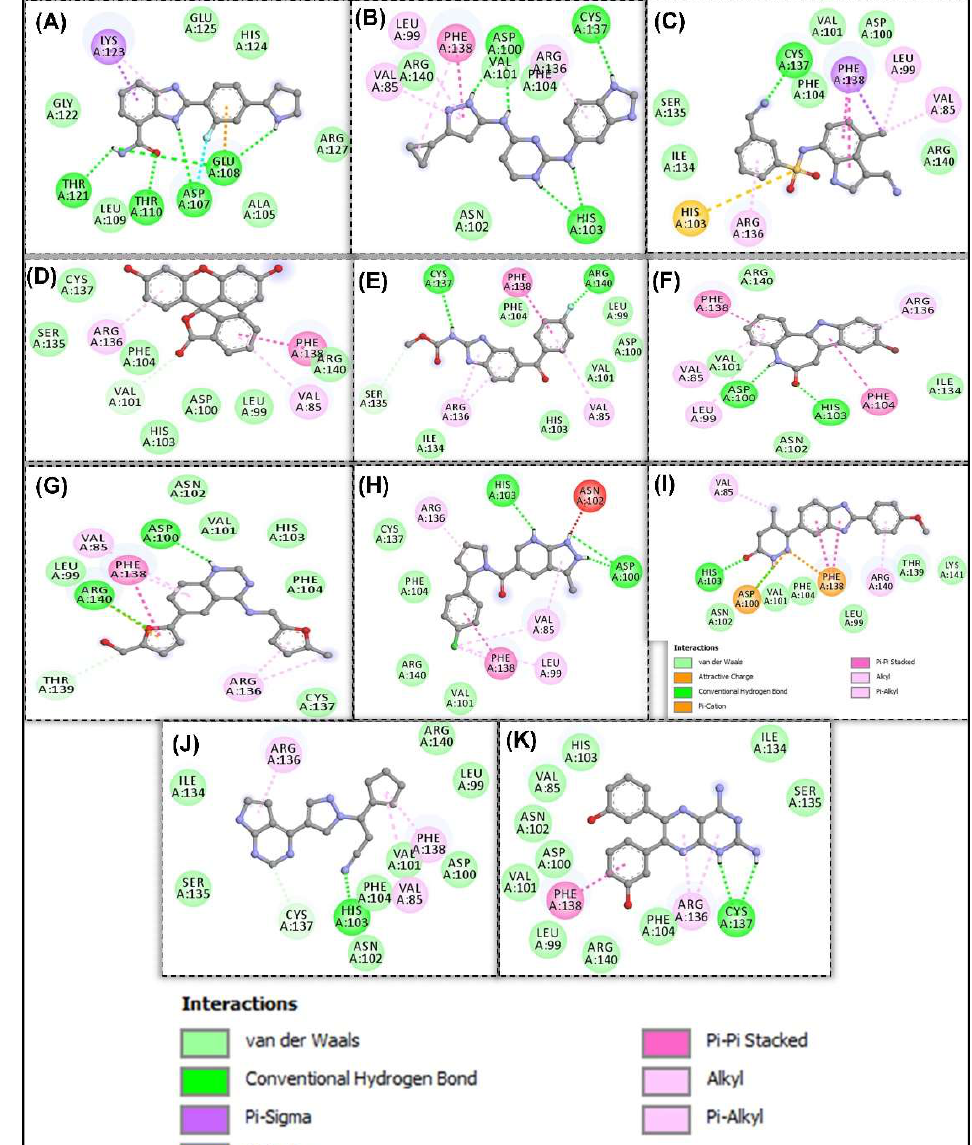
Table 2. The docking-derived binding affinity of anticancer compounds with good drug-like prop- erties against HSP27.